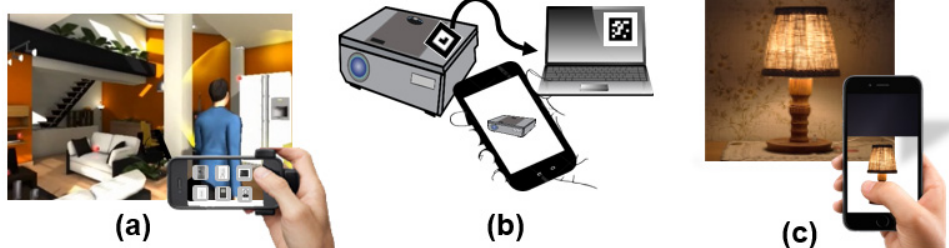
Figure 9. Various augmented reality (AR) interactions with Internet of Things (IoT) objects: ( a ) in situ/remote operation with traditional graphical user interface (GUI) button; ( b ) metaphorical natural interaction (virtual dragging) to invoke an object function [45]; ( c ) interacting in a virtual/augmented space to affect the physical world [11].